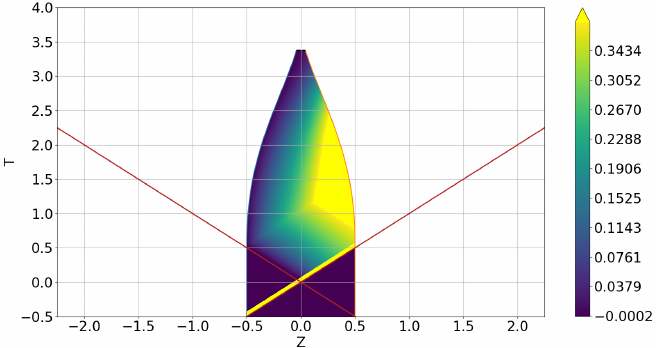
Figure 17. A contour plot of Ψ 4 for a = 128 and λ = 0.72 in the case of colliding impulsive